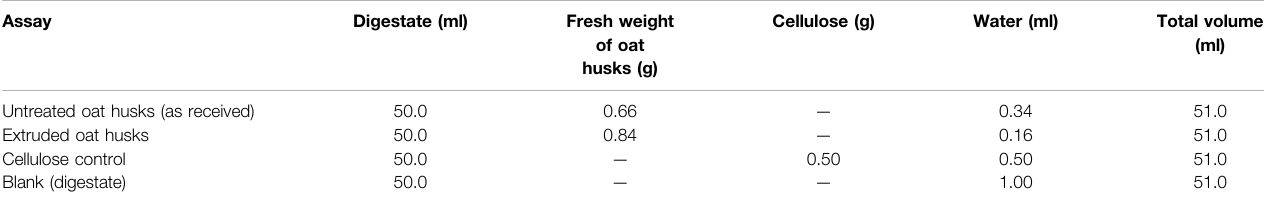
TABLE 2 | Biochemical methane potential assays loadings for each treatment. Assay Digestate